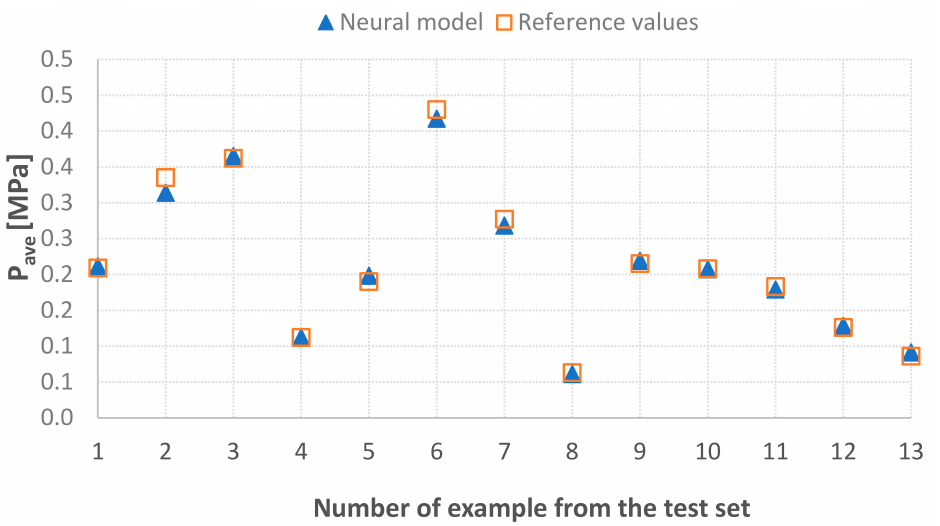
Figure 3. Summary of the determined values of the average methane seam pressure (p ave ) and the values returned by the neural